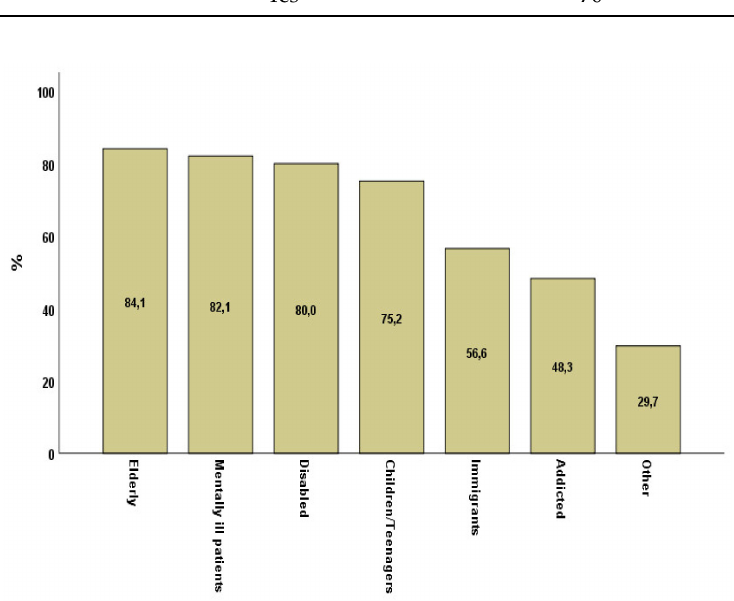
Figure 1. Categories of users of